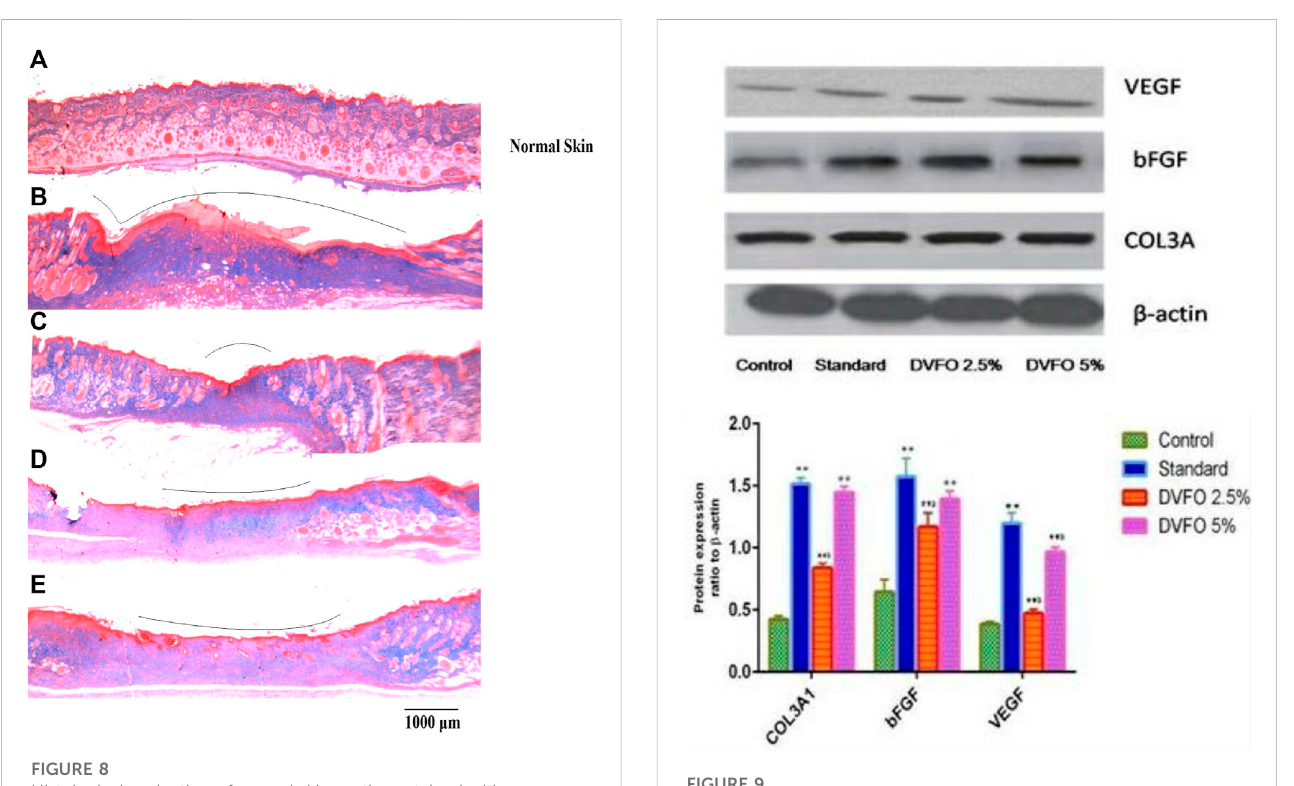
FIGURE 9 Western blot analysis of important growth factors involved in the regulation ofwoundhealingandregeneration.Theskintissue ofanimals treated with DVFO showed increased expression of FGF, VEGF and COL3A as compared to control. Values are expressed as Mean ± SEM. Statistical analysis was done by Kruskal – Wallis followed by